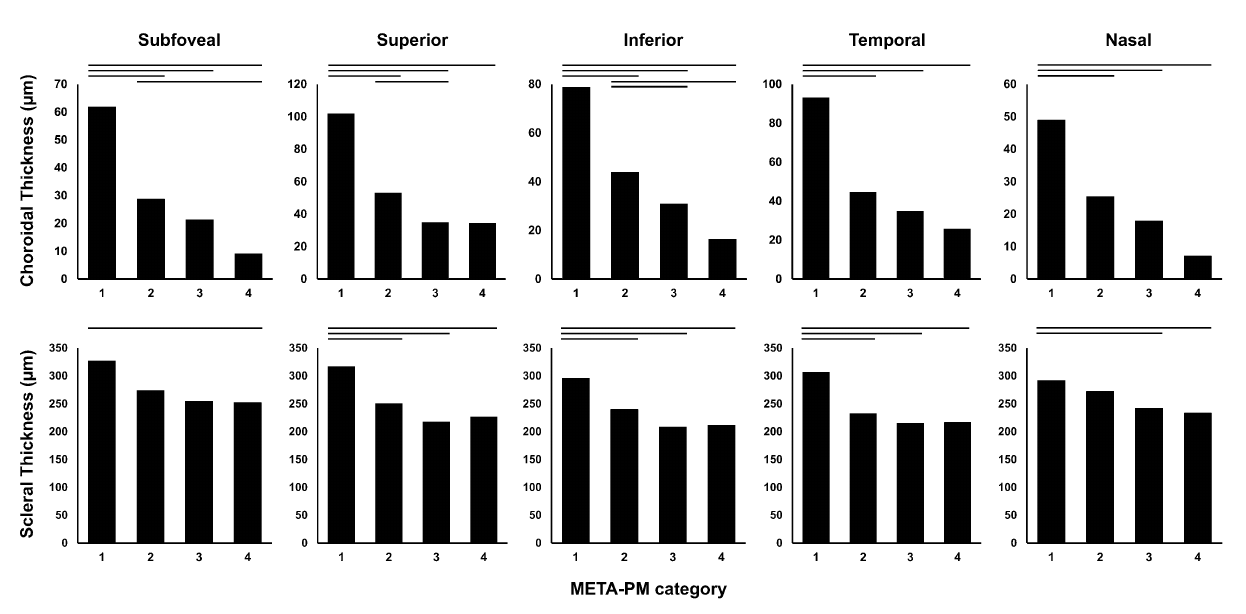
Figure 1. Choroidal and scleral thicknesses at the subfovea and at 3000 μm superior, inferior, temporal, and nasal to the fovea according to the category of myopic maculopathy based on the Meta-analysis of Pathologic Myopia Study Group classification. Horizontal bars indicate statistically significant differences between the categories after correction for multiple